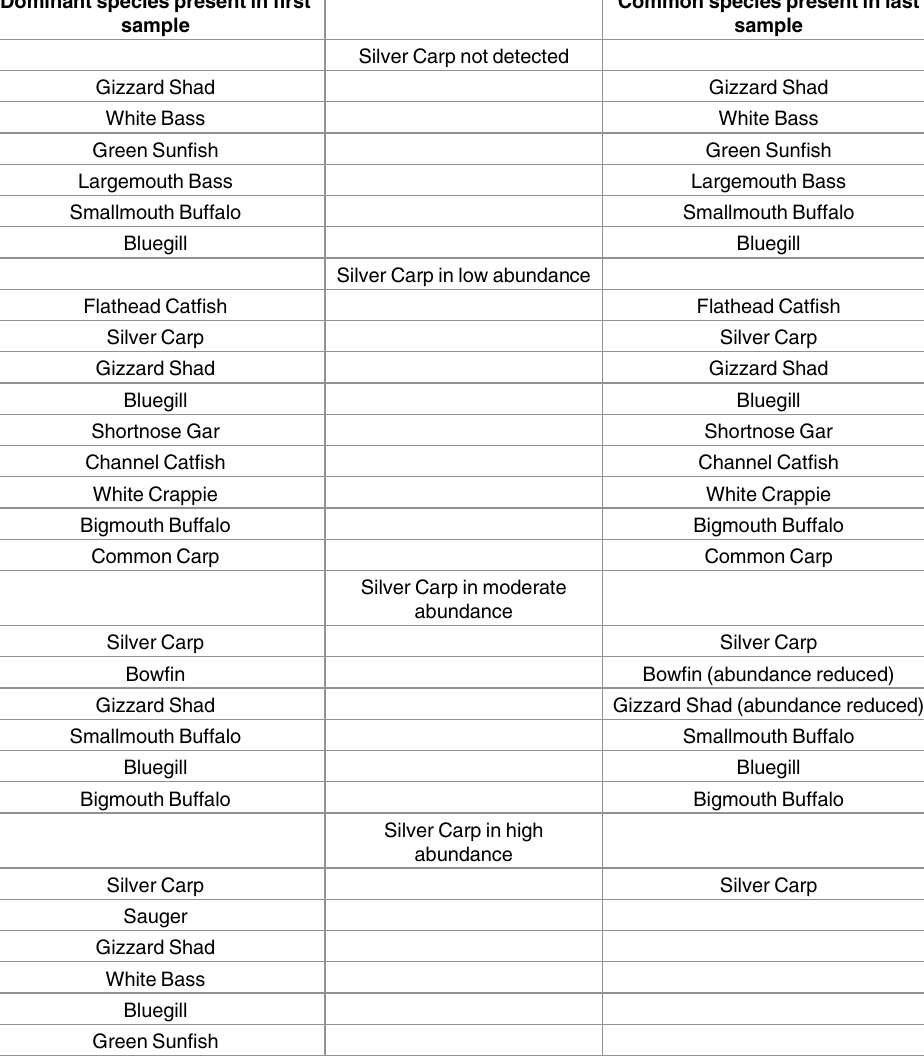
Table 3. A qualitative comparison of change in fish communities within floodplain lakes. A qualitative comparisonof change in fish communities within floodplainlakes of varyingSilver Carp abundances using presence/not detected data. Only commonly collectedtaxa are shown duringthe first and last sampling events. A reduction in abundanceis shown with grey